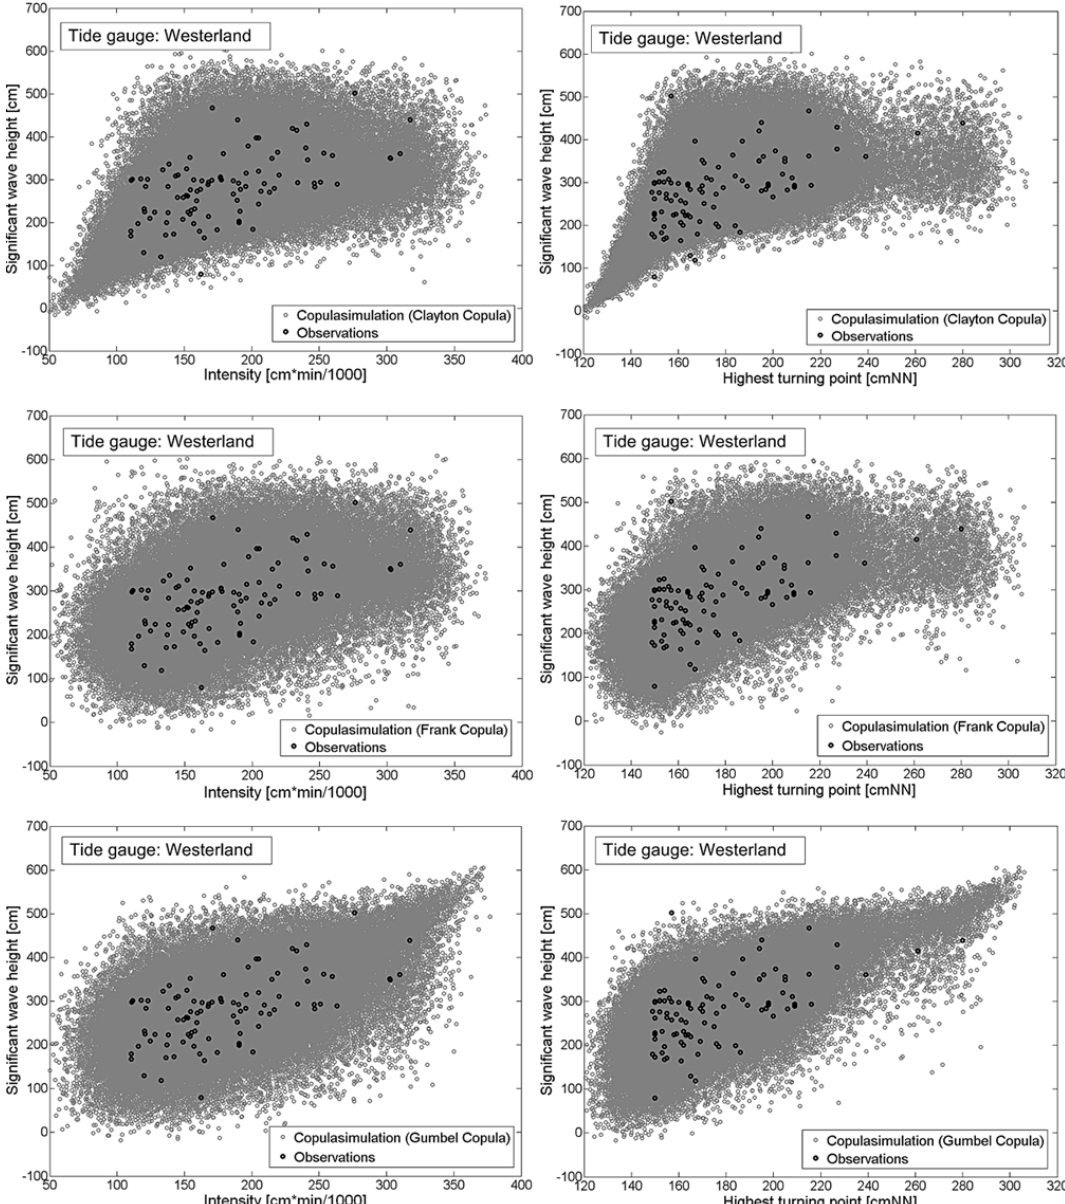
Fig. 10. Results from a graphical based GoF test for the tide gauge of Westerland by considering the Clayton Copula (top), the Frank Copula (middle), the Gumbel Copula (bottom) and the parameter pairs ( F,H s ) (left) and ( S,H s ) (right).